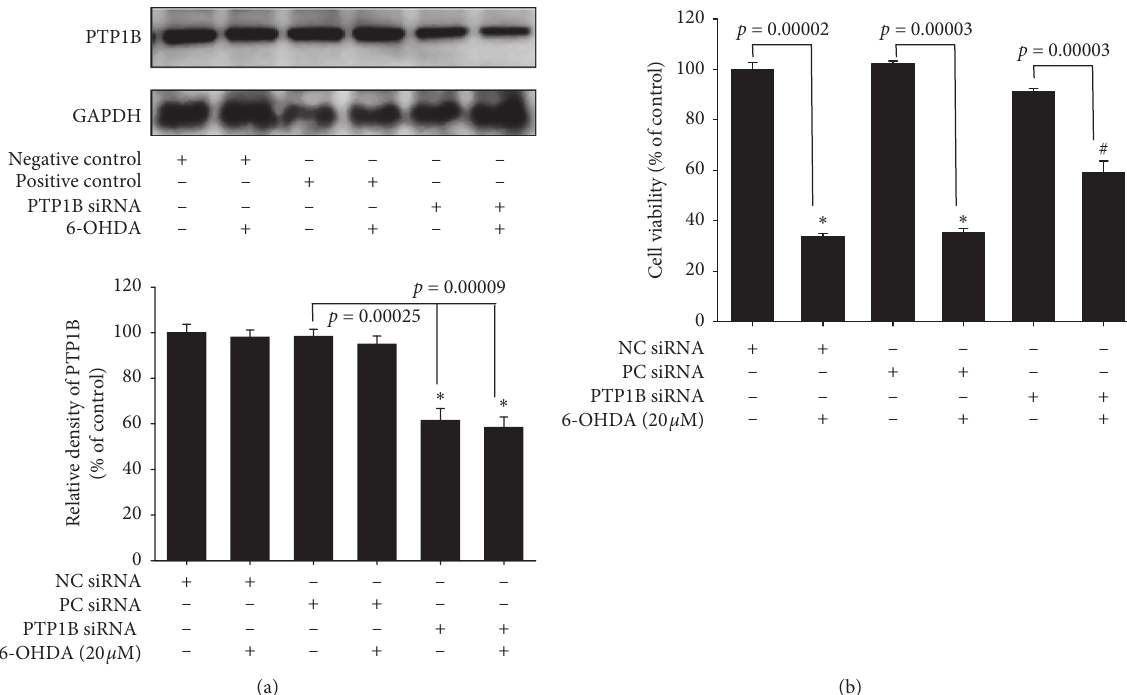
Figure 4: Effect of PTP1B knockdown in SH-SY5Y on PTP1B expression and neuroprotective effect against 6-OHDA damage. (a) SH-SY5Y cells were transfected with siRNAs by LipofectAMINE PlusReagent for 3 h and incubated with new medium overnight. Western blotting for PTP1B of the control (negative control), 6-OHDA (negative control), control (positive control), 6-OHDA (positive control), control (PTP1B siRNA), and 6-OHDA (PTP1B siRNA) groups is shown. Data are presented as mean ± SEM, and each value contains three replicates and three samples. ∗ Significantly different from the control (negative control) group. (b) SH-SY5Y cells were transfected with siRNAs by LipofectAMINE PlusReagent for 3 h and incubated with new medium overnight. Cell viability of the control (negative control), 6-OHDA (negative control), control (positive control), 6-OHDA (positive control), control (PTP1B siRNA), and 6-OHDA (PTP1B siRNA) groups is measured. Data are presented as mean ± SEM, and each value contains three replicates and three samples. ∗ Significantly different from the control (negative control) group. # Significantly different from the 6-OHDA (negative control)